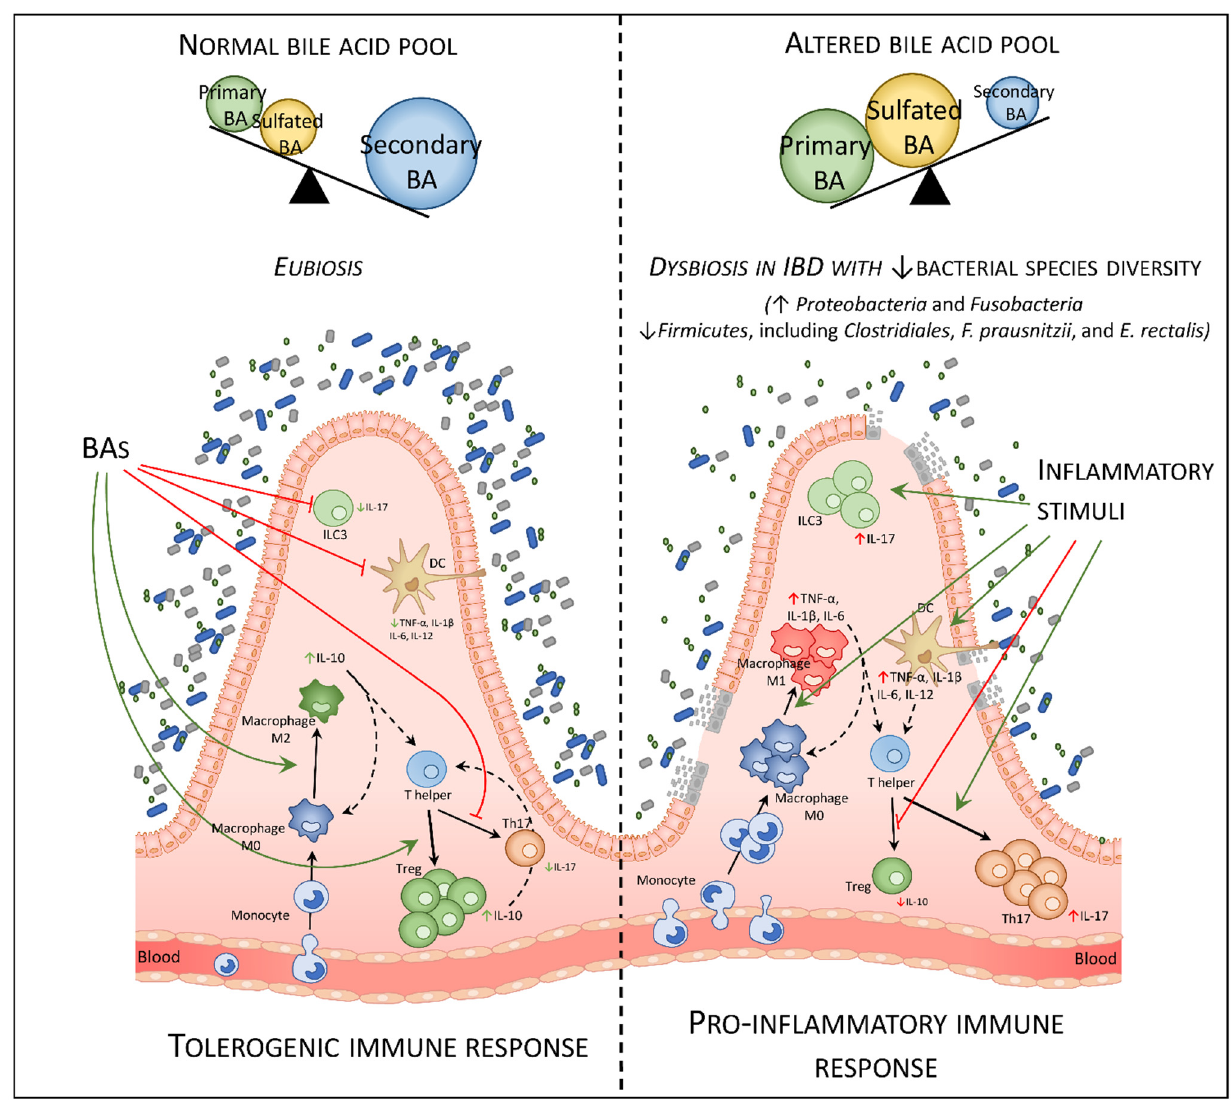
Figure 1. Microbiota, bile acid pool, and regulation of intestinal immunity. In a healthy condition, the majority of bile acids are actively reabsorbed by the enterocytes by apical transporter ASBT, and are transported back to the liver through the portal blood, thus limiting BA loss through feces to 3%–5% of daily secreted BAs. BAs reaching the colon are metabolized by the intestinal microbiota which transforms primary bile acids into secondary bile acids and other derivatives which therefore make up the majority of the bile acid pool. BAs through agonism on FXR and GPBAR1 and antagonism on ROR γ t (inverse agonism) regulate the immune system by inducing a tolerogenic response. The action on these receptors induces the polarization of macrophages and helper T cells towards an anti-inflammatory phenotype, respectively macrophages M2 and Treg, with the up-regulation of IL-10 production, and inhibits the activation of DCs, ILC3, and Th17 by reducing the production of pro-inflammatory cytokines (i.e., IL-6, IL-1 β , TNF- α , and IL-17). In patients with IBDs, the alterations of the intestinal epithelium reduce the reabsorption of bile acids and therefore increase the quantity of bile acids that are eliminated with the feces. Furthermore, patients with IBDs have a dysbiosis of the intestinal bacterial flora with a decrease in bacterial species diversity, which strongly decreases the enzymatic capacity of the microbiota, resulting in a lower ability to metabolize primary bile acids into secondary bile acids and other derivatives. After breach of the epithelial barrier, or pathogenic invasion, molecules like LPS activate macrophages, DCs, and ILC3, inducing the production of pro-inflammatory cytokines, IFN- γ , TNF- α , IL-6, IL-1 β , and IL-17, with an increase in the polarization of M0 macrophages toward a pro-inflammatory M1 phenotype. M1 macrophages and activated DCs therefore induce production of effector T cells (i.e., Th17) and up-regulation of the expression of chemokine CCL2 in the colon, which recalls more monocytes from the blood to the lamina propria of the